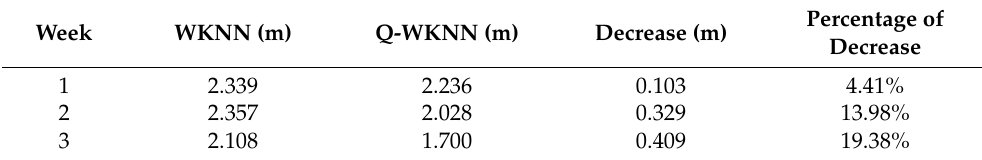
Table 2. Q effect on three weeks of Park